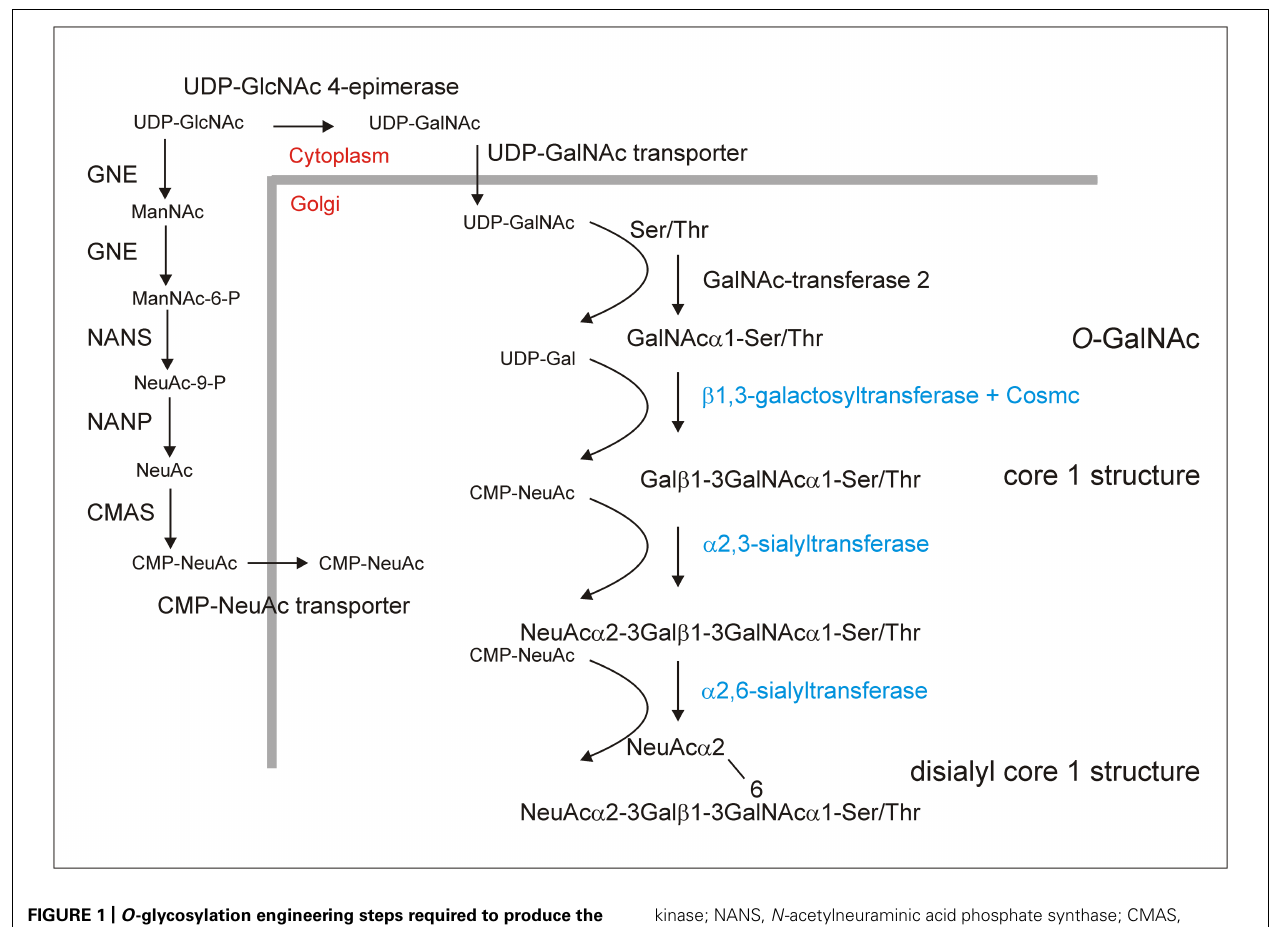
FIGURE 1 | O -glycosylation engineering steps required to produce the disialylated core 1 structure which is, for example, the major O -glycan on Ser-126 of human EPO (Tsuda etal., 1990). In addition to providing CMP-NeuAc in the Golgi and initiation of O -glycosylation by transfer of a GalNAc residue the biosynthesis requires the expression of a mammalian core 1 β 1,3-galactosyltransferase together with its specific chaperone Cosmc as well as α 2,3- and α 2,6-sialyltransferases (Gill etal., 2011; Ju etal., 2011). These steps are depicted in blue and have not been engineered into plants so far.The generation of O -GalNAc residues has been shown (Daskalova etal., 2010;Yang etal., 2012) and the successful expression of the enzymes (GNE, UDP- N -acetylglucosamine 2-epimerase/ N -acetylmannosamine